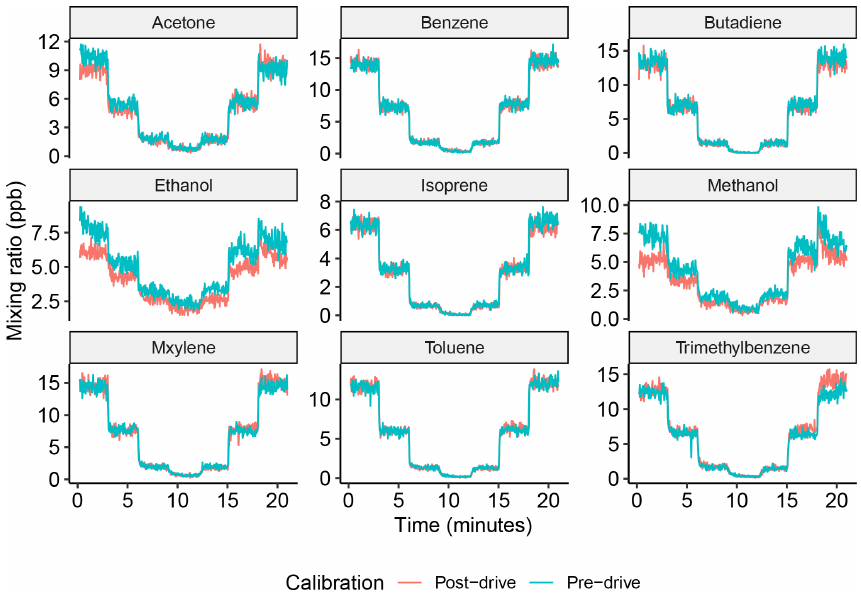
Figure 5. Multi-point calibration for VOC gas standard compounds over 10, 5, 1 and 0ppb. The blue line shows the calibrations performed pre-drive, and the pink line shows the calibration performed post-drive. Table 3. The coefficient of determination ( R 2 ) and the ion counts per second per part per billion (cpsppb − 1 ) calculated from the SIFT-MS calibrations. The limit of detection (LoD) and precision of compounds measured by the SIFT-MS (in ppb) for every 2.5s measurement. Compounds in the upper part of the table were externally